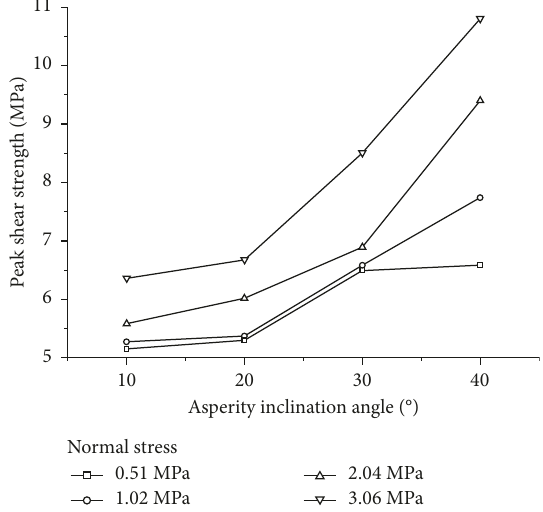
Figure 13: Relationship between peak shear strengths and asperity inclination angles under different normal stresses.